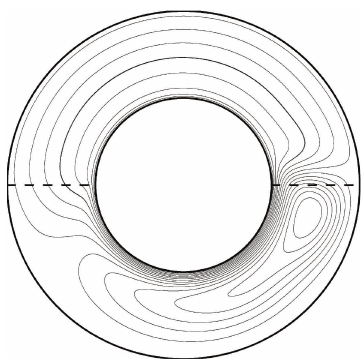
Figure 5: Distribution of the contours of stream function for a semicircular external magnetic fluid of Ha (cid:8) 30 (cid:2)Δ ψ (cid:8) 0 . 0025 (cid:3)